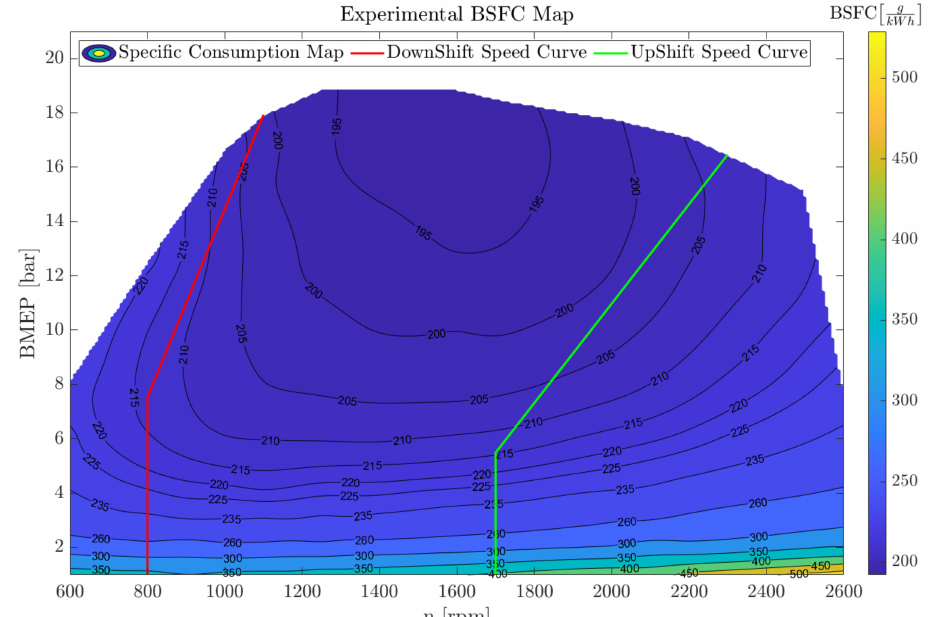
Figure 11. Gear shift lines corresponding to a six-speed manual gearbox mounted on the studied inter-urban bus, reported on the BSFC map of the six-cylinder Diesel